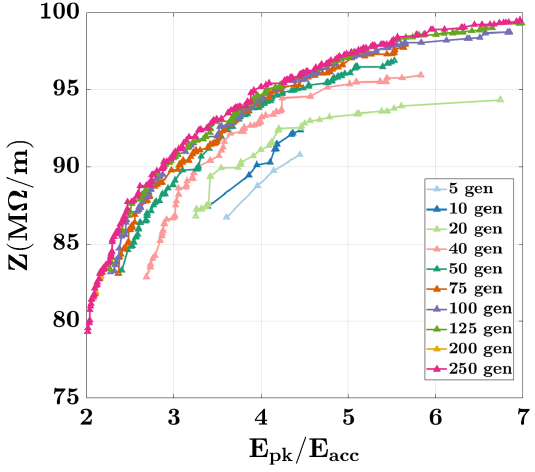
=E FIG. 5. Z vs E Pareto front convergence example pk acc showing how the Pareto front converges after 250 generations for the C-band standing wave (SW) structure.